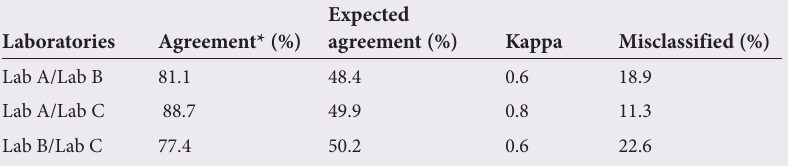
Table 4. Impact of CD4 variations at ART initiation threshold on treat- ment decision